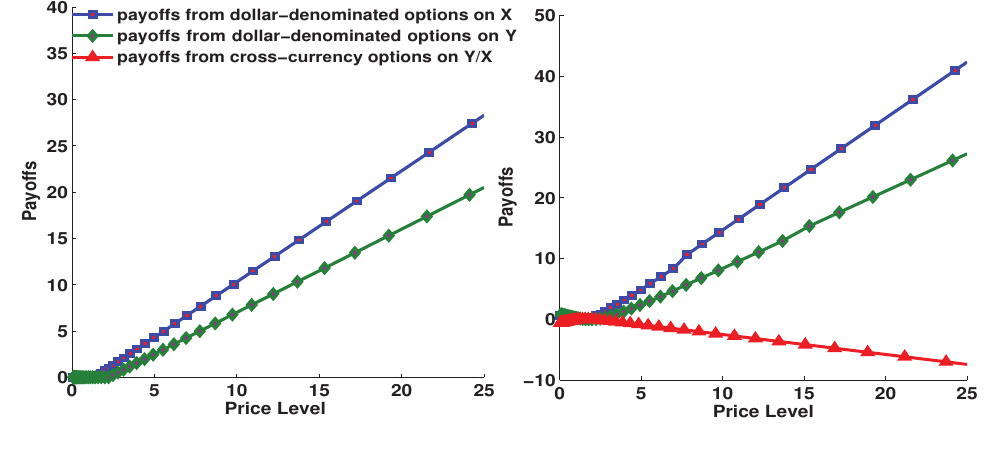
Figure 4. Terminal Payoffs to Dominating Strategies . The time-zero prices of the exchange rates X and Y are 1.6 and 2.5. The volatilities of the processes X and Y are 42%, and two processes are correlated with ρ = 0.20. Both the domestic and foreign interest rate are zero. The basket option with 1-year maturity has the payoff [ 1.2 X + 0.9 Y − 3.8 ] + . The dominating strategies are attained within a price mesh of u = 1.12 and J = 30. In the left panel, the relevant strike on X ( Y ) is 1.42 (2.23). In the right panel, the relevant strikes on the X ( Y ) are ( 1.02,1.28,1.79, 2.25 ) ( ( 1.59,1.78,2.80,3.14 ) ), and the strikes on Z are (1.24,1.75).